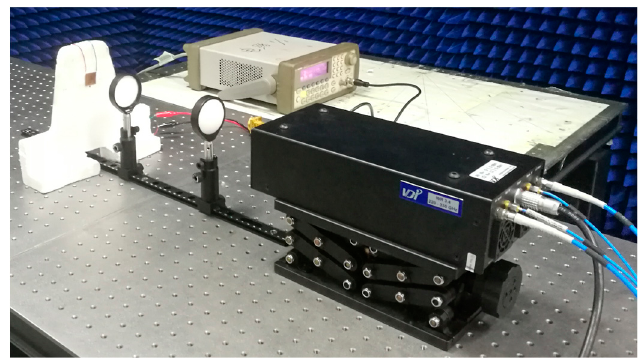
Figure 9. Measurement setup.